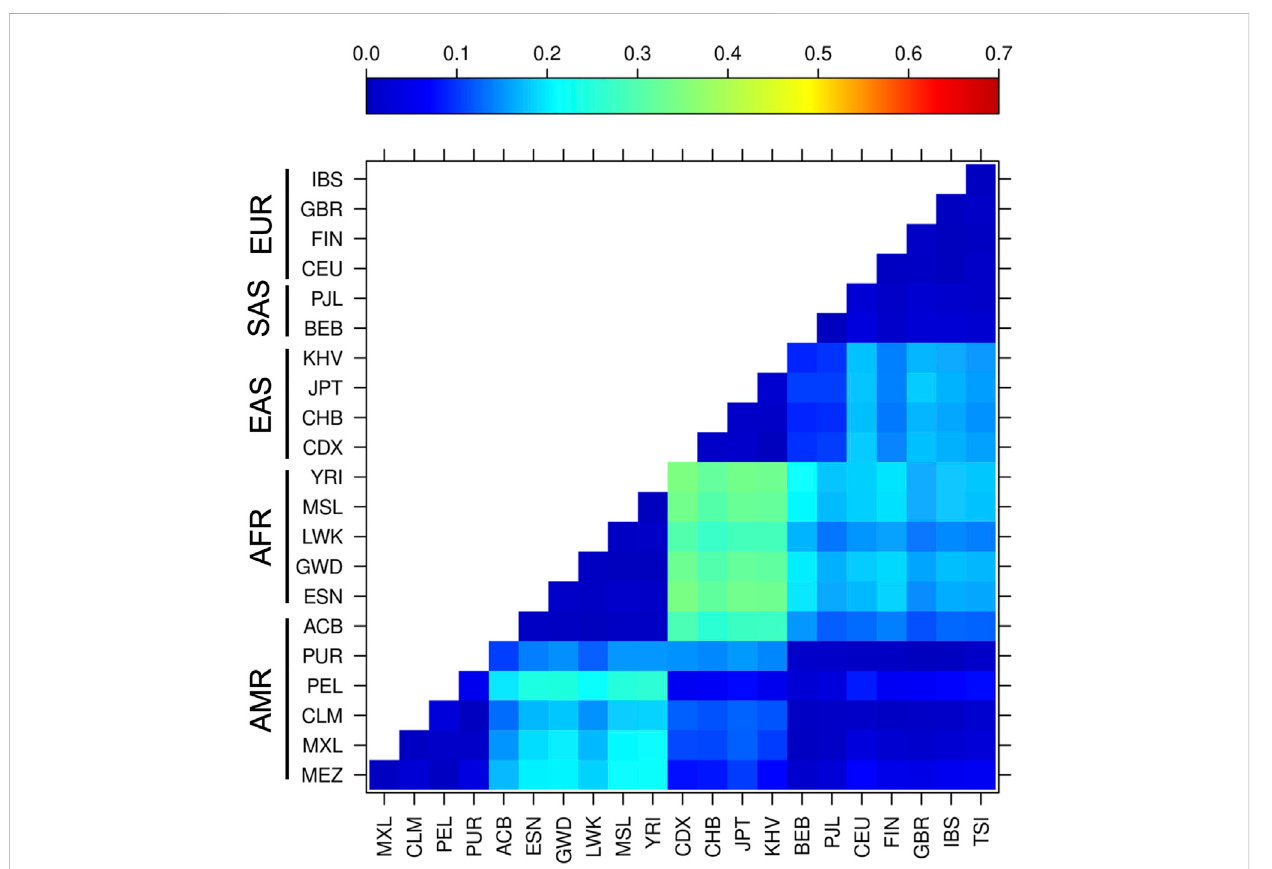
FIGURE 3 Genetic differentiation based on SNVs in components of the miRNA biosynthesis pathway. Pairwise F ST analysis of all variants in 21 populations with different ancestry from the 1,000 Genomes database and MEZ population. The darkest blue indicates the lowest levels of differentiation, whereas red indicates the highest levels of differentiation. Abbreviations are the same from Figure